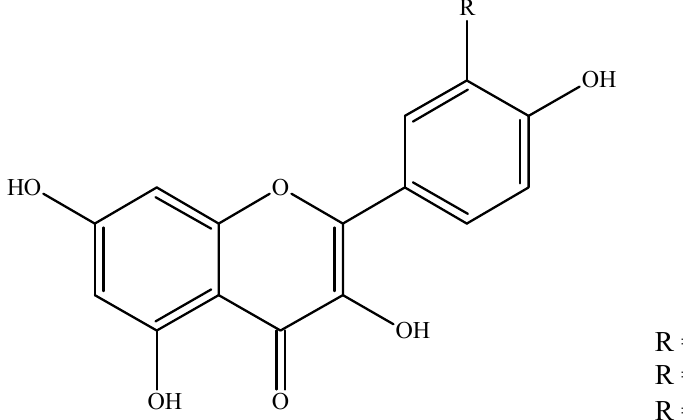
Figure 6. Structures of the most represented fl avonoids in Allium spp.